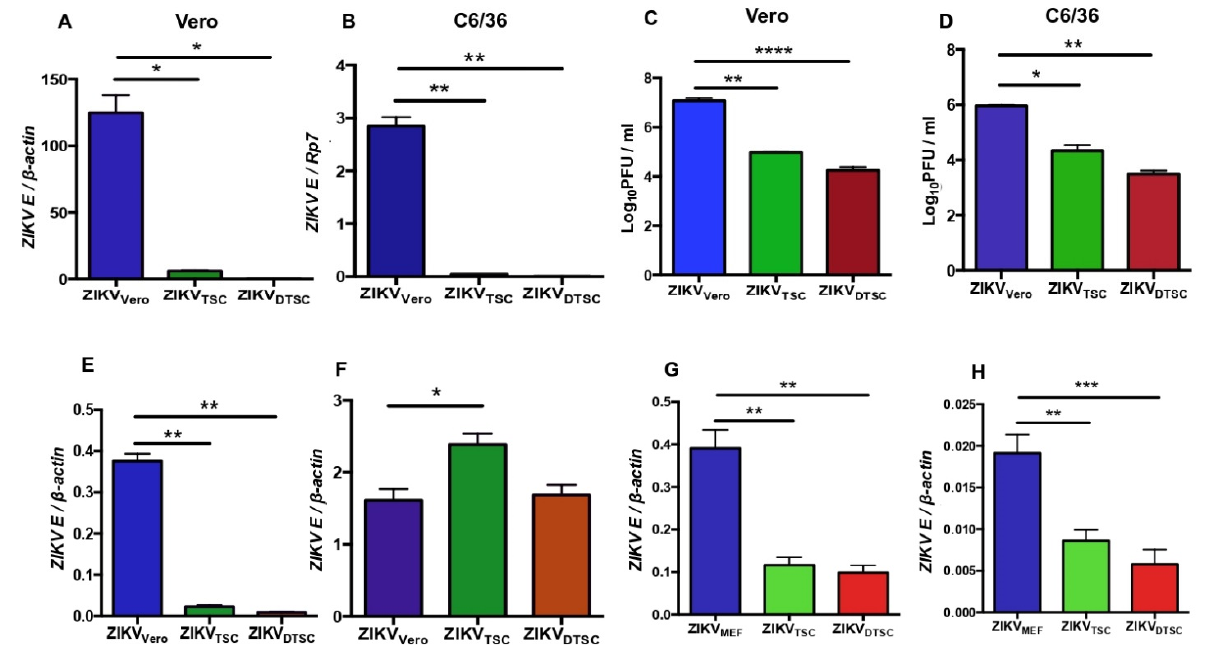
Figure 1. ZIKV generated in TSCs and DTSCs decreases infectivity. Vero cells and C6/36 were infected with ZIKV (MOI = 1) that was propagated in Vero cells (ZIKV Vero ), TSCs (ZIKV TSC ), or DTSCs (ZIKV DTSC ) for 24 h. The ratio of ZIKV to Vero β -actin ( A ) or C6/36 Rp7 ( B ) was determined by qPCR. ZIKV titers in the cell media were determined by plaque assay ( C , Vero and D , C6/36). ( E ) Vero cells were inoculated with 1 MOI of ZIKV Vero , ZIKV TSC , or ZIKV DTSC and incubated at 4 °C for 1 h. After washes, the attached viruses were quantified with qPCR. ( F ) Replication of ZIKV TSC and ZIKV DTSC after passaging one generation on Vero cells. Vero cells were infected with 1 MOI of the Vero ‐ generated ZIKV TSC or ZIKV DTSC for 24 h. The ratio of ZIKV to Vero β‐ actin was determined by qPCR. ( G , H ) Mouse embryonic fibroblasts (MEFs) were used as control cells to generate ZIKV MEF . ( G ) ZIKV (1 MOI) grown in MEFs, TSCs, and DTSCs were used to infect Vero cells for 24 h, and the levels of viral replication were quantified by qPCR by measuring ZIKV, normalized to cellular β‐ actin . ( H ) Vero cells were inoculated with ZIKV grown in different cells for 1 h at 4 °C, and the attached viruses were quantified by qPCR. The data are representative of at least two independent experiments and expressed as mean ± the standard errors of the mean (SEM). The results were analyzed by using a two ‐ tailed Student’s t ‐ test. *, **, ***, and **** denote p < 0.05, p < 0.01, p < 0.001, and p < 0.0001, respectively.